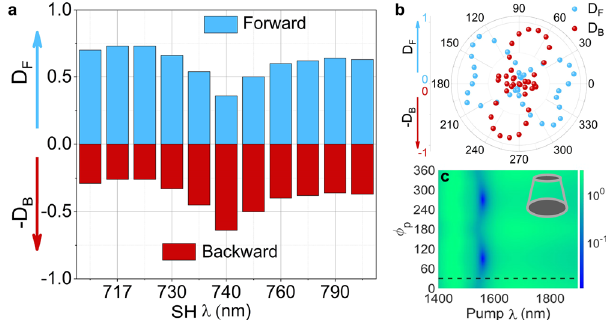
point as a function of ϕ . We further complement our p measurements by numerical simulations and in Fig. 7c we show = P SH Þ , as function the simulated SH directionality mapping, ð P SH F B ¼ 0. The measured data in of pump wavelength and ϕ for ϕ p a Fig. 7a corresponds to the horizontal dashed line in Fig. 7c. The is switching point of the SH directionality as a function of ϕ p ffi 80 o and ffi 260 o : In Fig. 7c, it can observed for two values ϕ p also be seen that the SH directionality switching occurs in the close vicinity of the ED mode, which can be triggered either as a function of the pump wavelength or polarisation. In contrast, the directionality of the SH emission is symmetric at the MQ and MD resonances. A good agreement can be observed between the experimental and simulated directionality data. The difference between the measured and simulated data might be because of the directionality being sensitive to the exact shape of the fabricated MoS 2 meta-atoms, such as the tapering angle and the surface roughness.